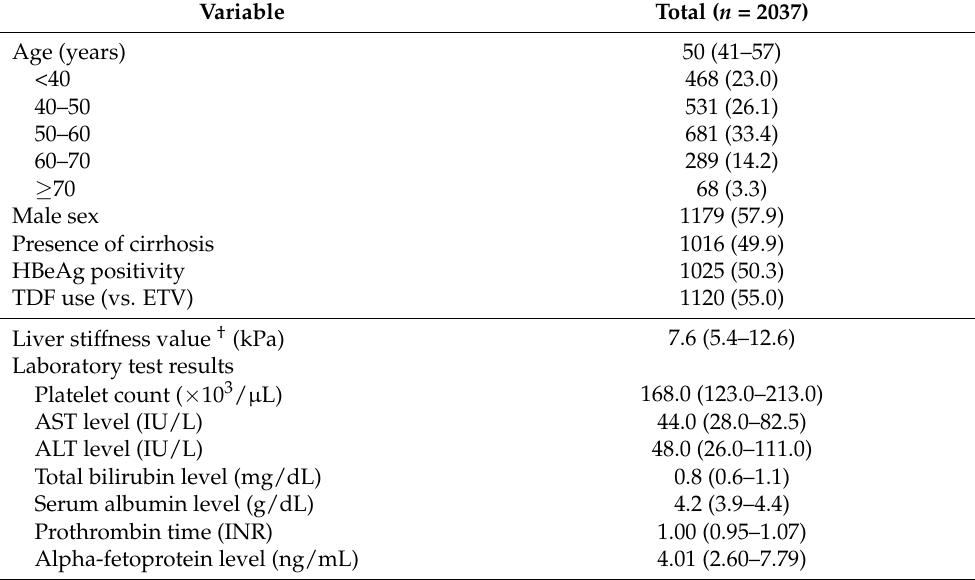
Table 1. Baseline characteristics of study population.